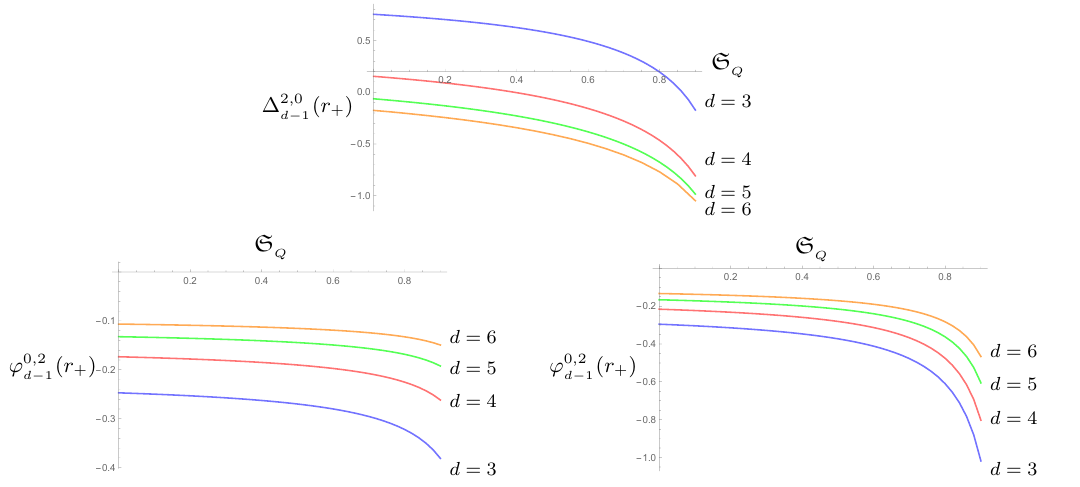
Figure 4 . The charge dependence of the coefficients in Green’s function of the Markovian vector polarizations X in dimensions d = 3 , . . . , 6 . Since X is non-Markovian of index M = 1 − d , the α α functions entering it are obtained by analytically continuing those for a Markovian field of index M = d − 1 . The latter happily happens to coincide with the tensor graviton polarizations, so the data above enters both K in and K in . Our conventions are as described in figure X d − 1